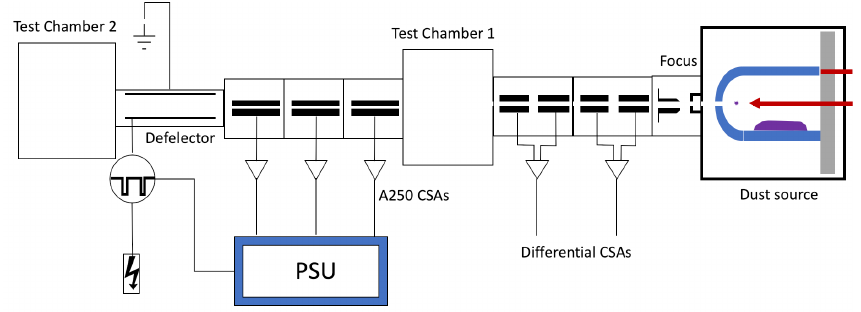
Figure 2. Schematic of the entire system of the upgraded small dust accelerator.